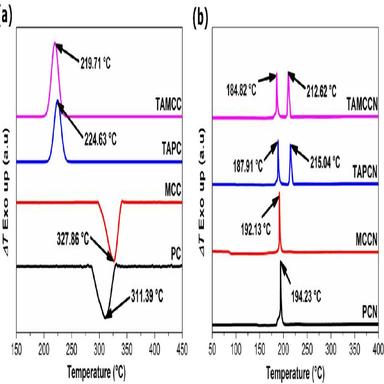
DTA curves of (a) functionalized and non-functionalized polymers; (b) nitrated unmodified and chemical-modified polymers.